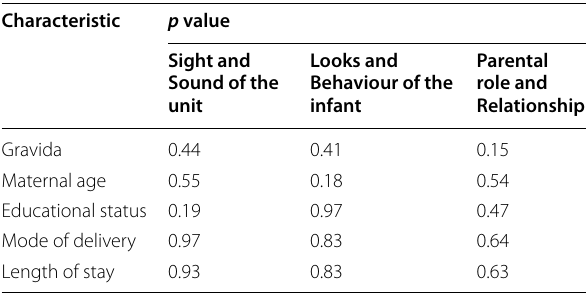
Table 1 Correlation of demographic data with components of PSS:NICU scale